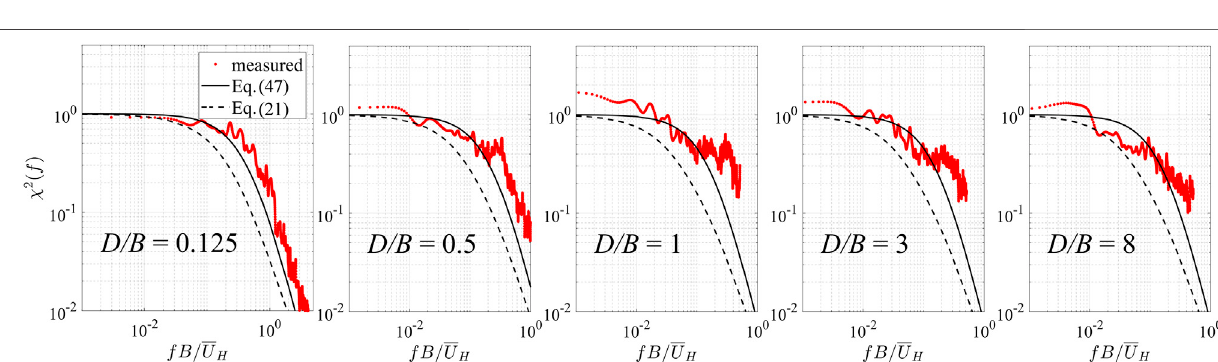
FIGURE 8 | Aerodynamic admittance functions for area-averaged fl uctuating pressure coef fi cients on the leeward wall.